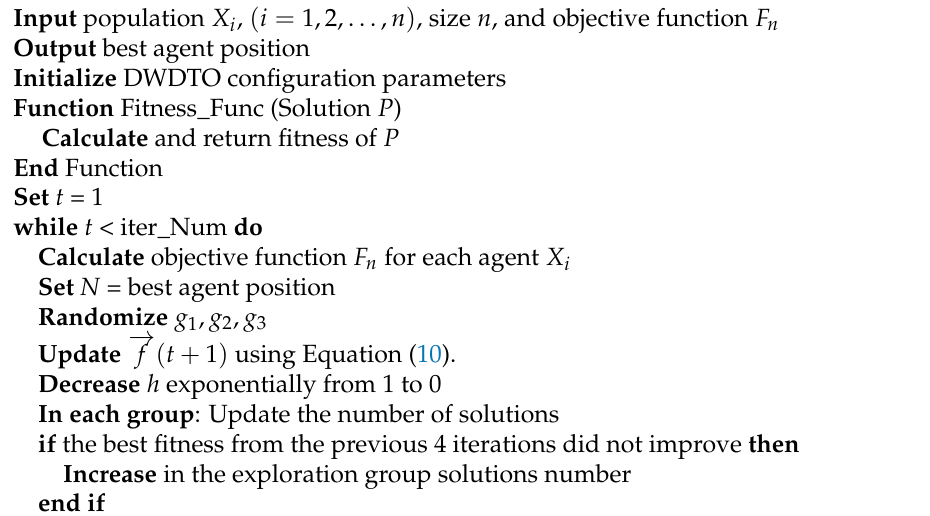
Algorithm 2 The Proposed DWDTO